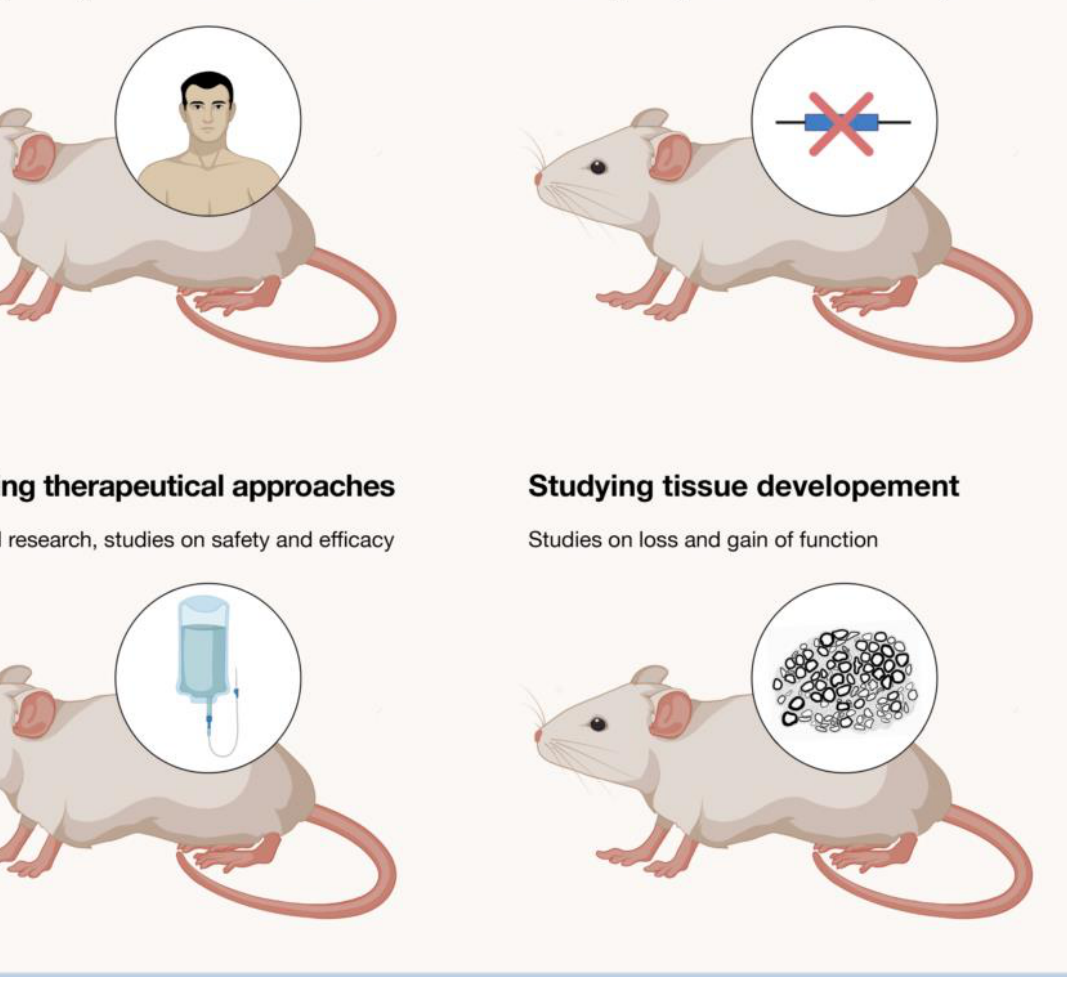
Figure 1. Use of rodent models in IPNs.